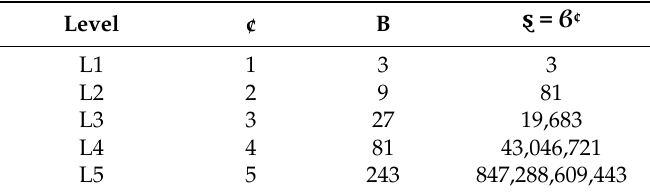
Table 1. Password space of proposed technique up to level 5.